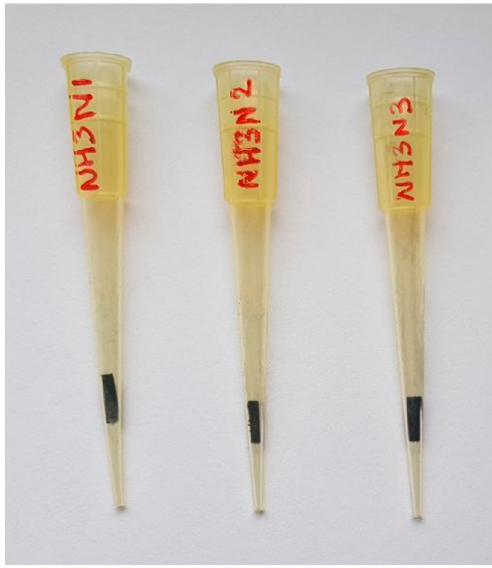
Figure 1. Three different pipette tip extraction units containing carbon nanohorn suprastructures coated over conventional paper as a sorptive phase. The phase is mechanically fixed to the narrower section of the tip and in close contact with its inner walls.